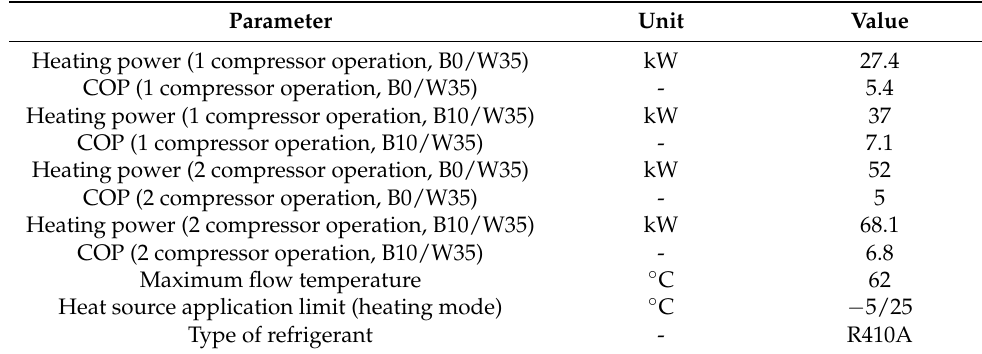
Table 3. Technical data heat pump SI 50TU, manufactured by the Dimplex company.